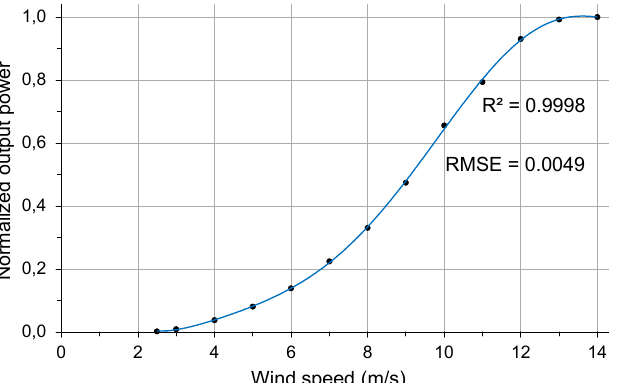
Figure 6. Approximation of the nonlinear section of the normalized power curve of an Enercon E-40 to a sixth-order polynomial (blue line) with the corresponding coefficient of determination (R 2 ) and root-mean-square error (RMSE). The black dots on the blue line mark the normalized values determined from the discrete values shown in Figure 2 and given in the manufacturer’s datasheet [16].